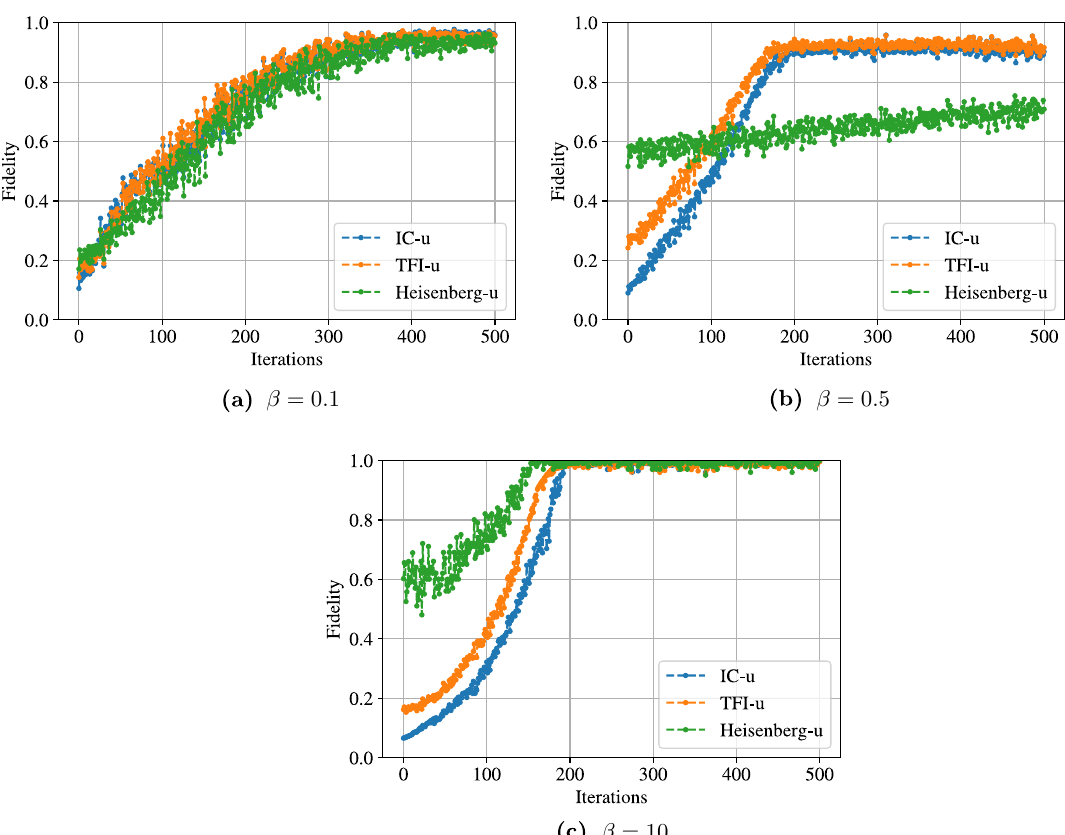
4 . We observe in all =